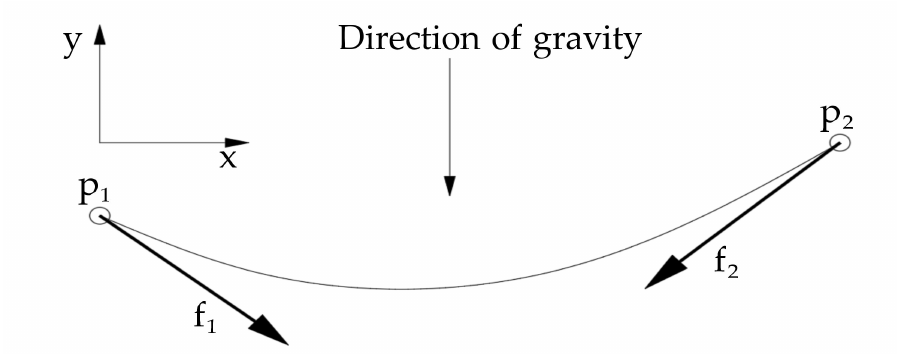
Figure 1. The cable and its